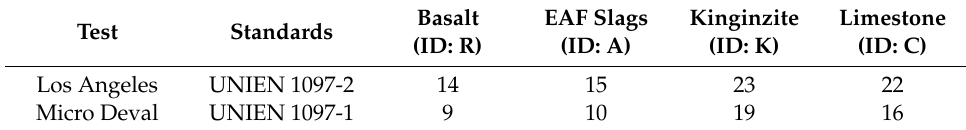
Table 2. Main mechanical properties of aggregates.